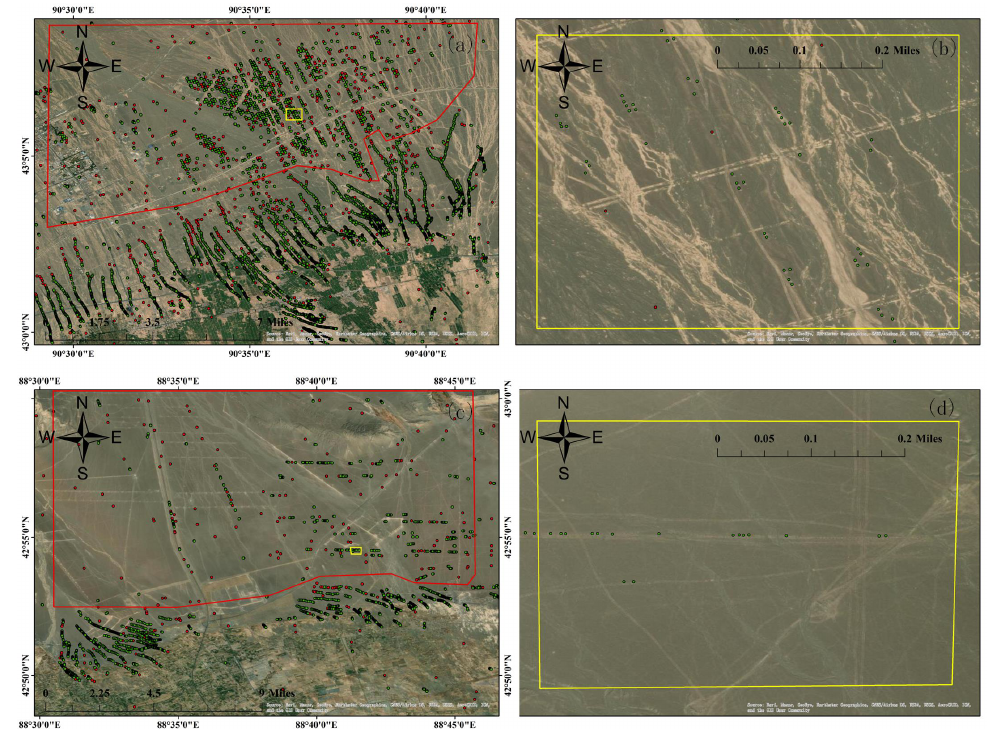
Figure 10. Some karez in Shanshan and Toksun County, Turpan, the base map is World_Imagery in ArcGIS. The red points are the negative karez points identified in the post-processing step, and the green points are the karez shafts retained after the post-processing step. ( b ) is an enlarged view of the yellow box range in ( a ). ( d ) is an enlarged view of the yellow box range in ( c